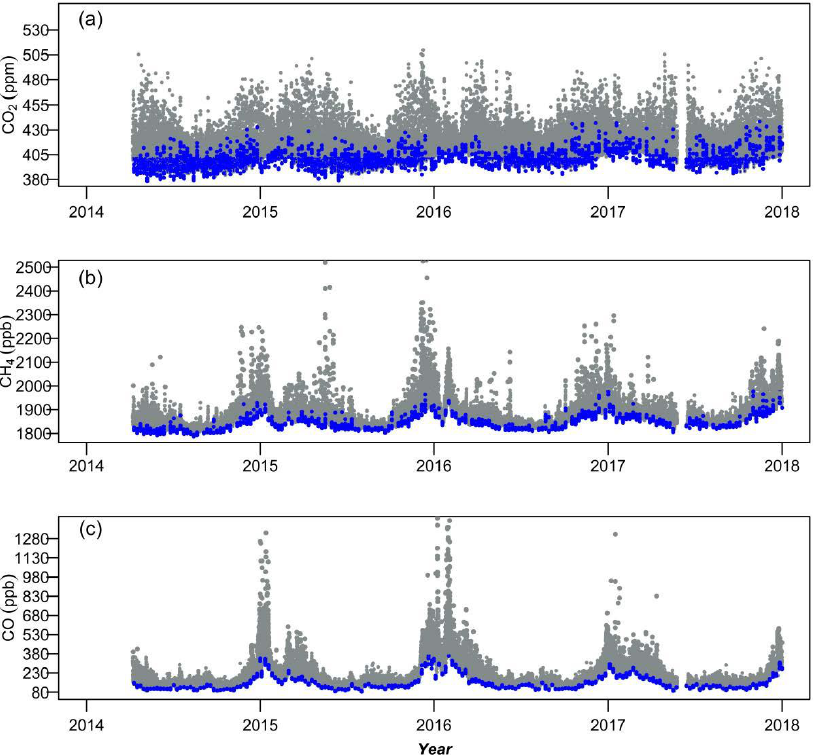
Figure 5. Time-series of atmospheric CO 2 ( a ), CH 4 ( b ), and CO ( c ) concentrations (in black) measured at the LTO station over the 2014–2017 period. The blue color represents the background obtained by the percentile method.